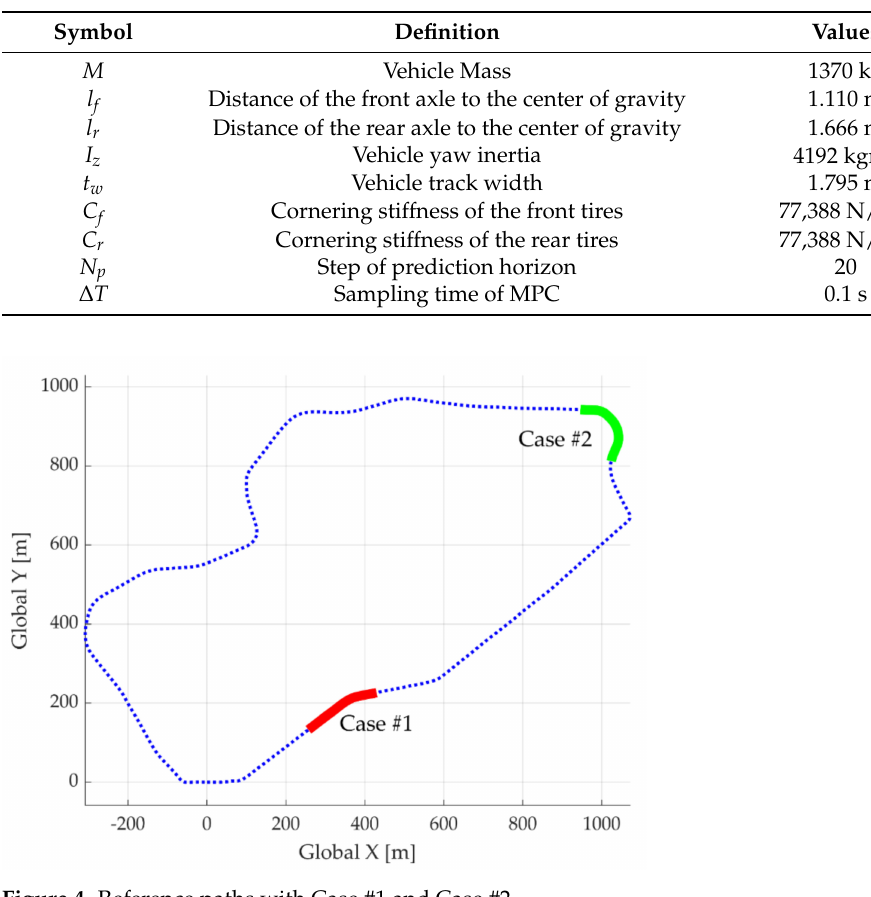
Table 2. Parameters for the simulation study.